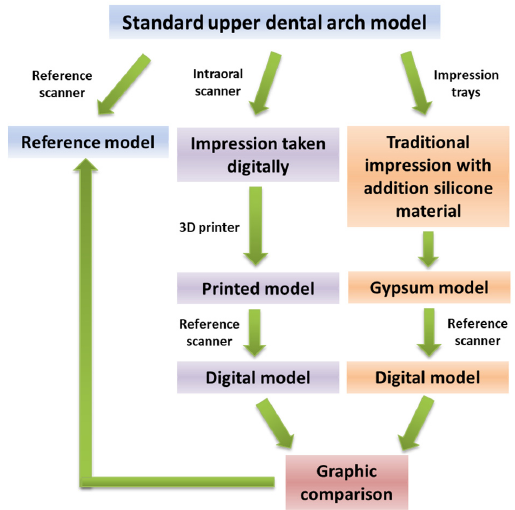
Figure 1. The scheme of mutual comparison of models obtained by traditional and digital methods to the reference model.